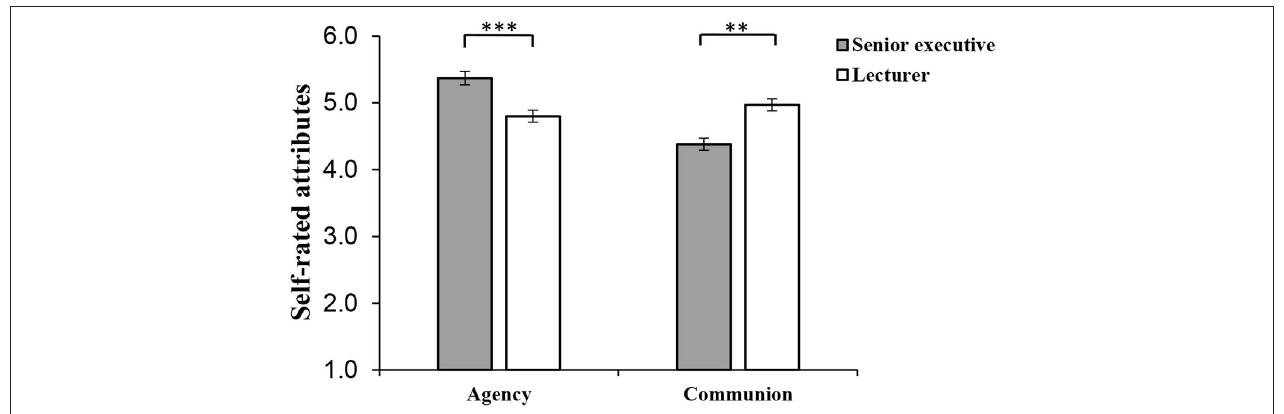
FIGURE 5 | Self-reported agency and communion at work for female senior executives and women lecturers in Study 3. Error bars represent the standard error of the mean. *** p < 0.001, ** p < 0.01. N = 202 women ( N Executive = 96, N Lecturer = 106).